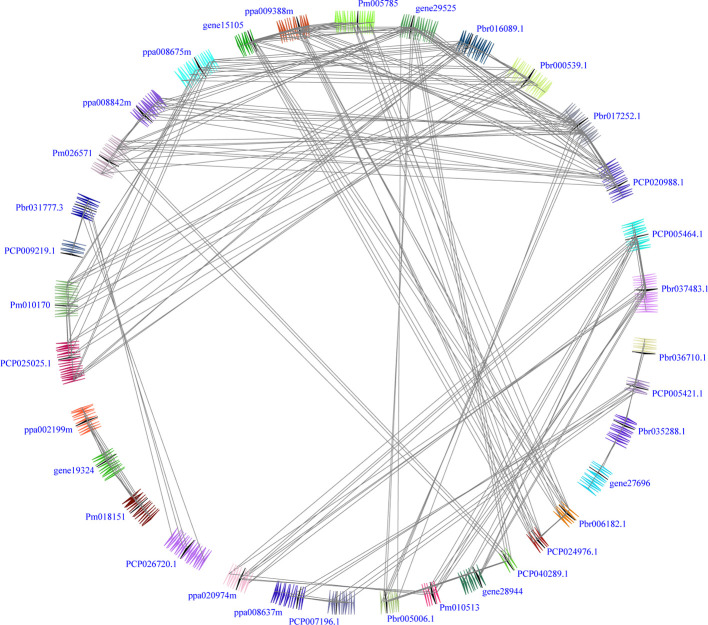
Interspecies microsynteny of BZR genes in five Rosaceae genomes, including Fragaria vesca, Prunus mume, Prunus persica, Pyrus communis and Pyrus bretschneideri. Genomic fragments are suggested by numbers of triangles. Black triangle represented BZR genes, and same color indicated these genes in the same fragment.